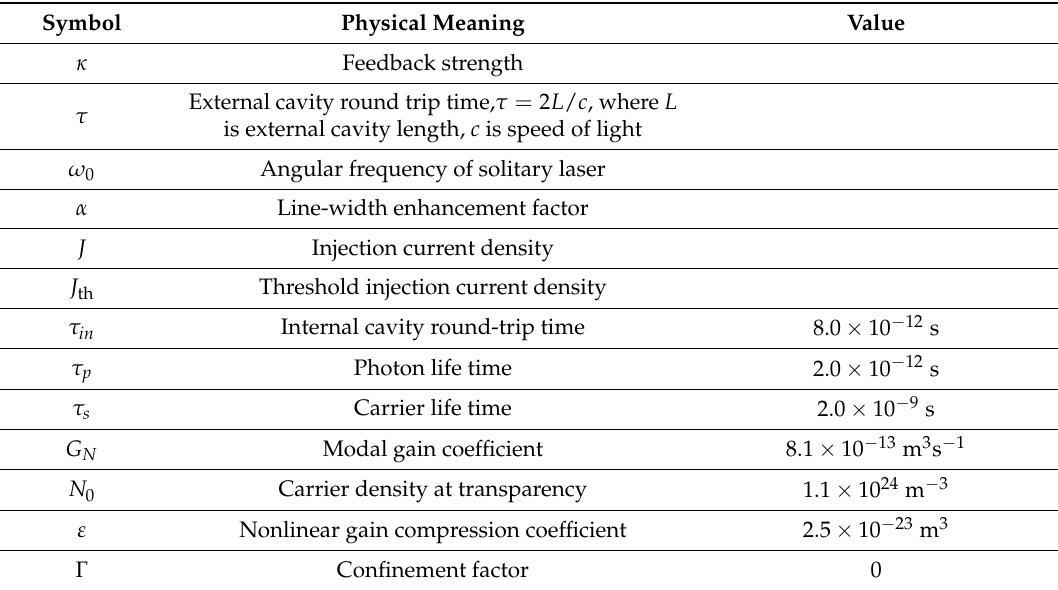
Table 1. Physical meaning of symbols in Equations